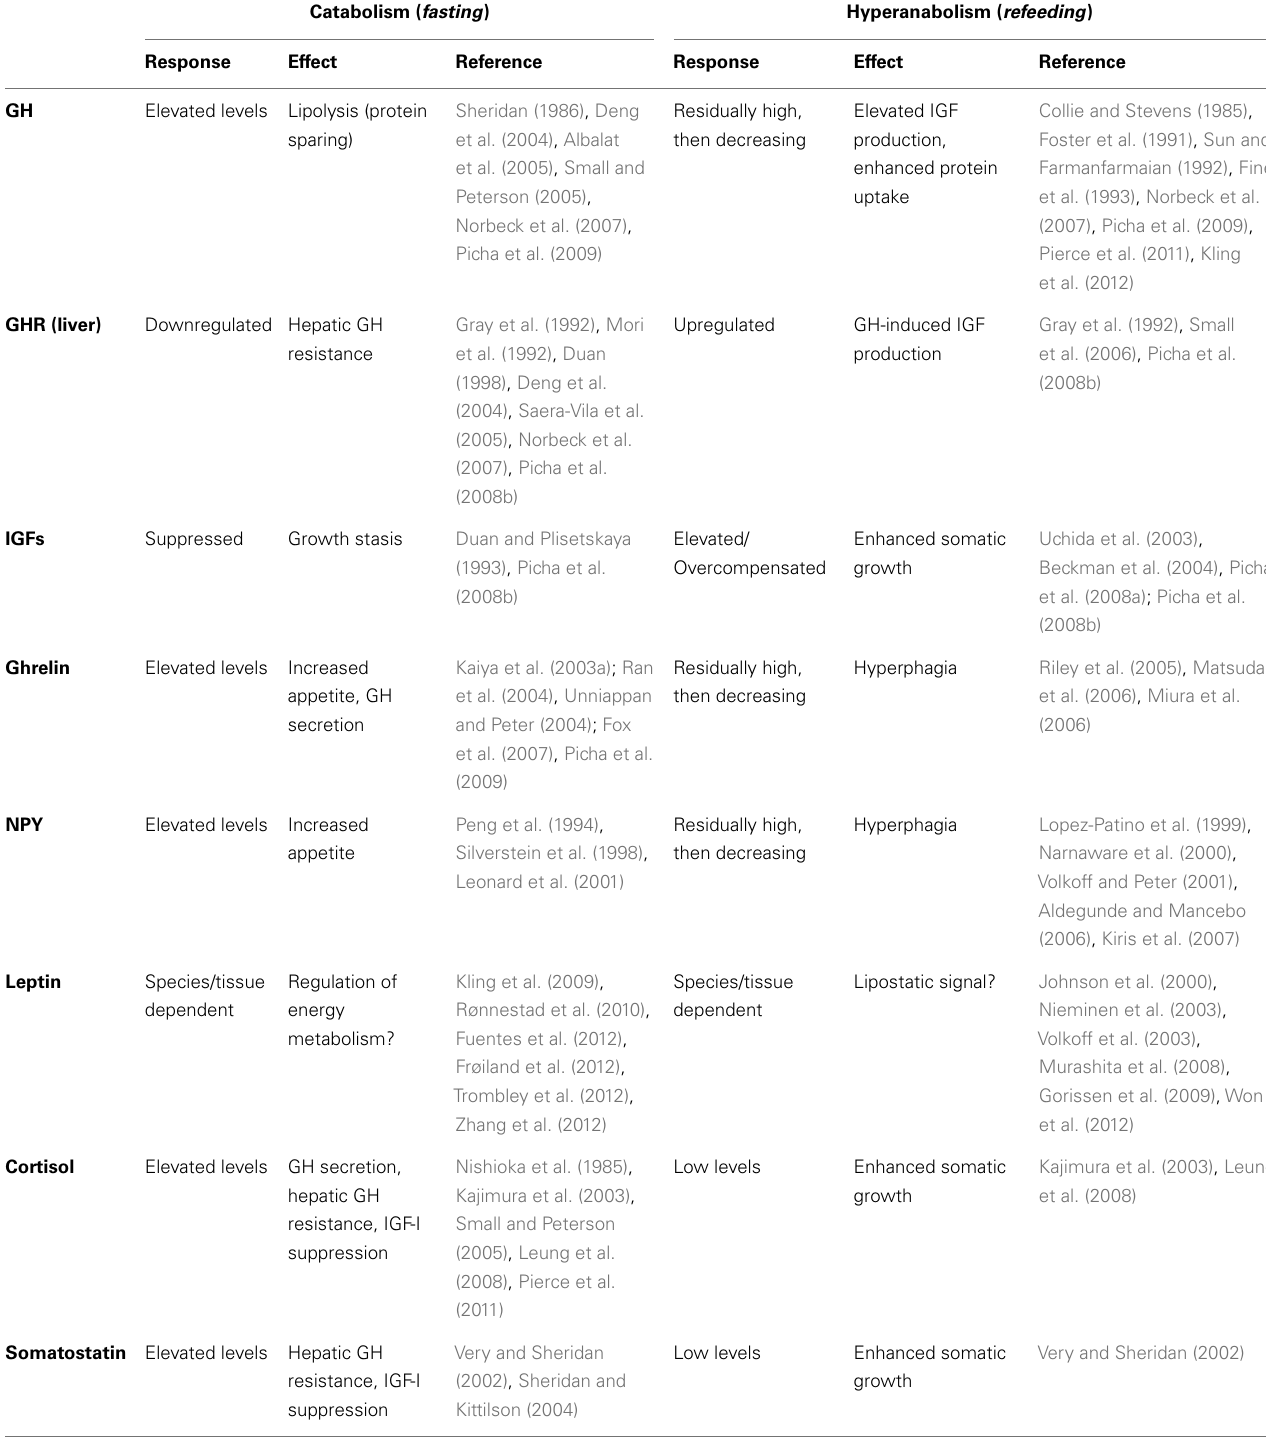
Table 1 | Modulation of select endocrine factors during the transition from catabolism (fasting) to hyperanabolism